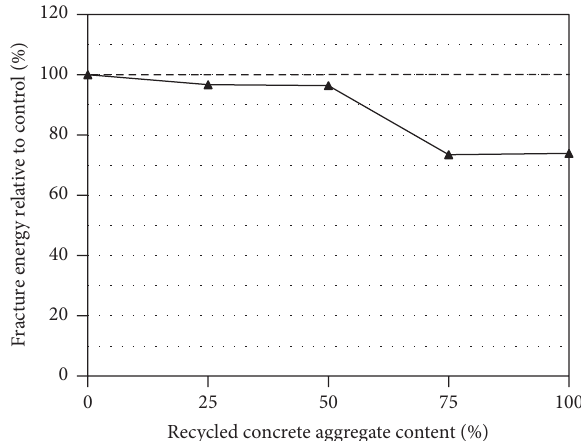
Figure 7: Influence of RCA coarse aggregate content on fracture